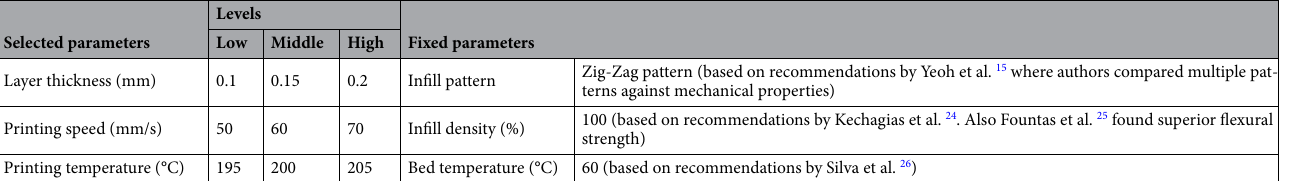
Table 2. Investigated and fixed